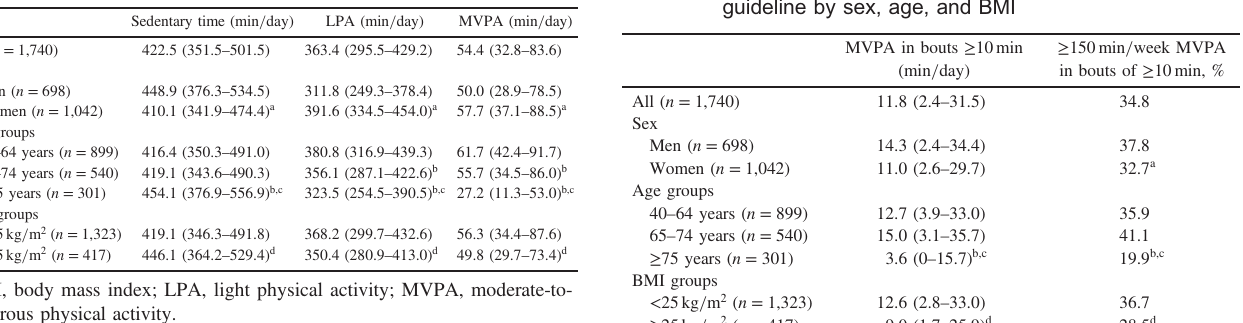
Table 1. Volume of sedentary time and physical activity by sex, age, and BMI groups